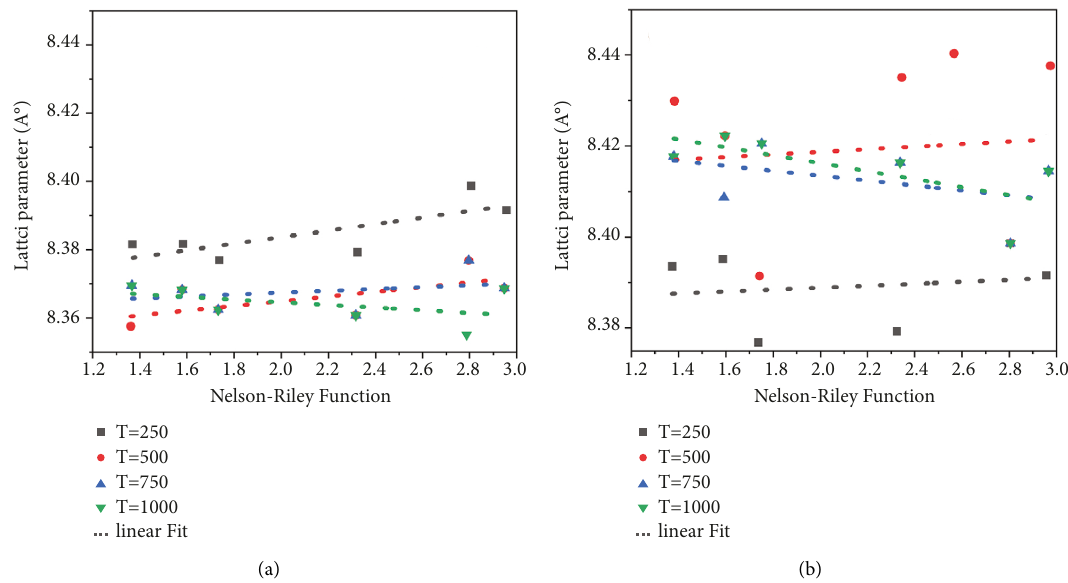
Figure 3: Nelson–Riley plot for Ni � 0.25 and (b) 0.75 at different annealing temperatures. 1-x Zn x Fe 2 O 4 ferrites for (a) x